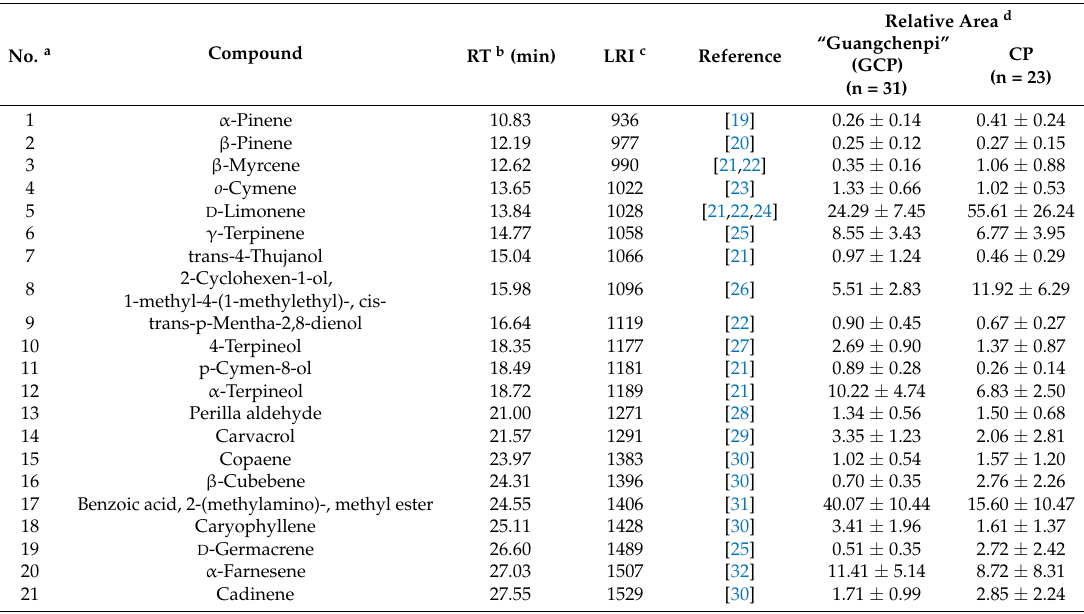
Table 2. Identification of volatile compounds in Citri reticulatae pericarpium